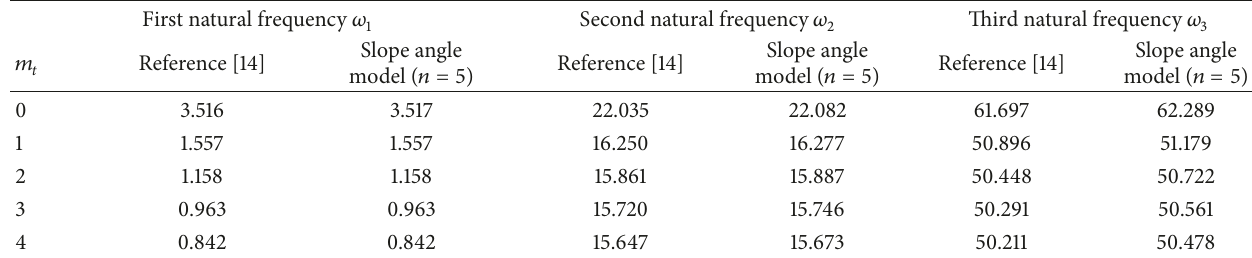
Figure 3: Variations of first four dimensionless natural frequencies 𝜔 𝑖 as functions of rotating angular velocity Ω and tip mass 𝑚 𝑡 for hub radius ratio 𝑟 0 = 0 : (a) first natural frequency 𝜔 1 ; (b) second natural frequency 𝜔 2 ; (c) third natural frequency 𝜔 3 ; and (d) fourth natural frequency 𝜔 4 . Table 1: Comparison of the first three dimensionless natural frequencies of the rotating hub-beam system with a tip mass in [14] for 𝑟 0 = 0 and Ω = 0